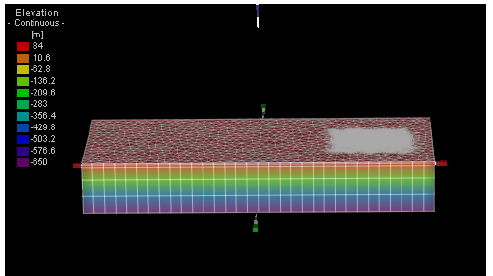
Figure 3. Generalized model of the Baiquan Underground Reservoir. Table 1. Reference parameters of different soil